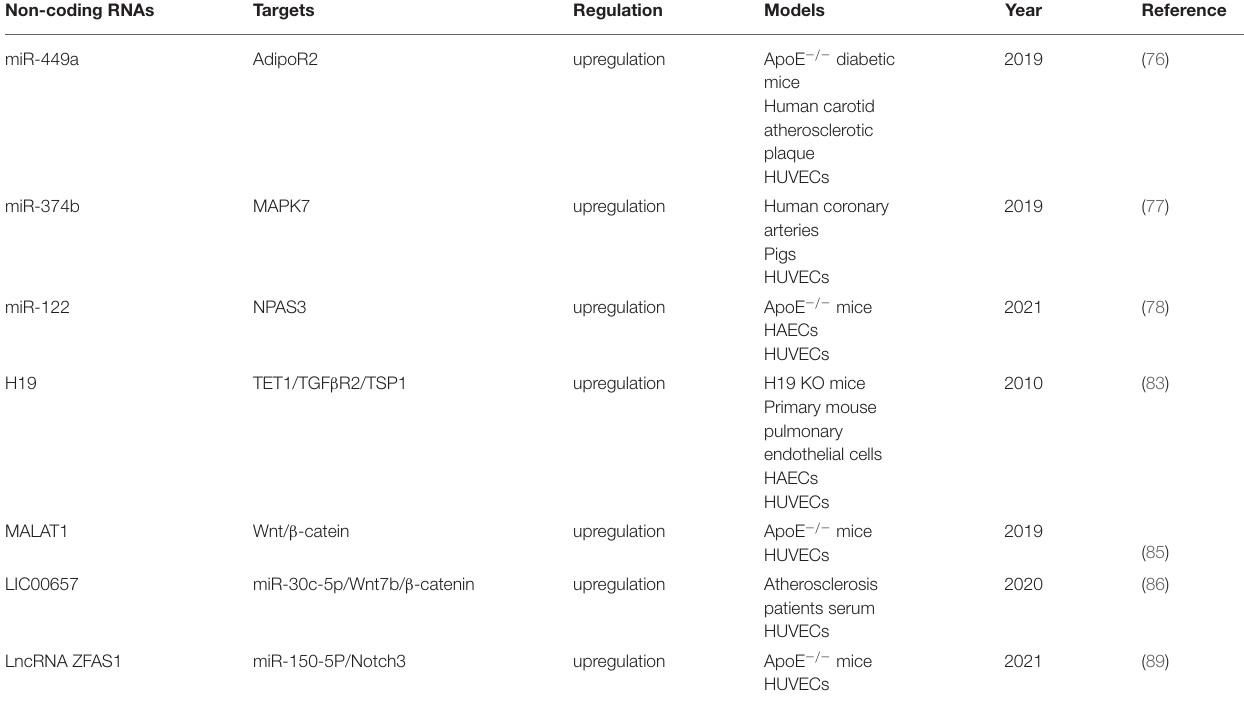
List of non-coding RNAs regulating EndMT associated with atherosclerosis including miRNA and lncRNAs. AdipoR2, Adiponectin receptor 2; MAPK7, Mitogen-activated protein kinase 7; NPAS3, Neuronal PAS Domain Protein 3; TET1, Tet Methylcytosine Dioxygenase 1; TGF β R2, TGF- β receptor 2; TSP1, Thrombospondin 1; MALAT1, Metastasis-associated lung adenocarcinoma transcript 1; HUVECs, Human umbilical vein endothelial cells; HAECs, Human Aortic Endothelial